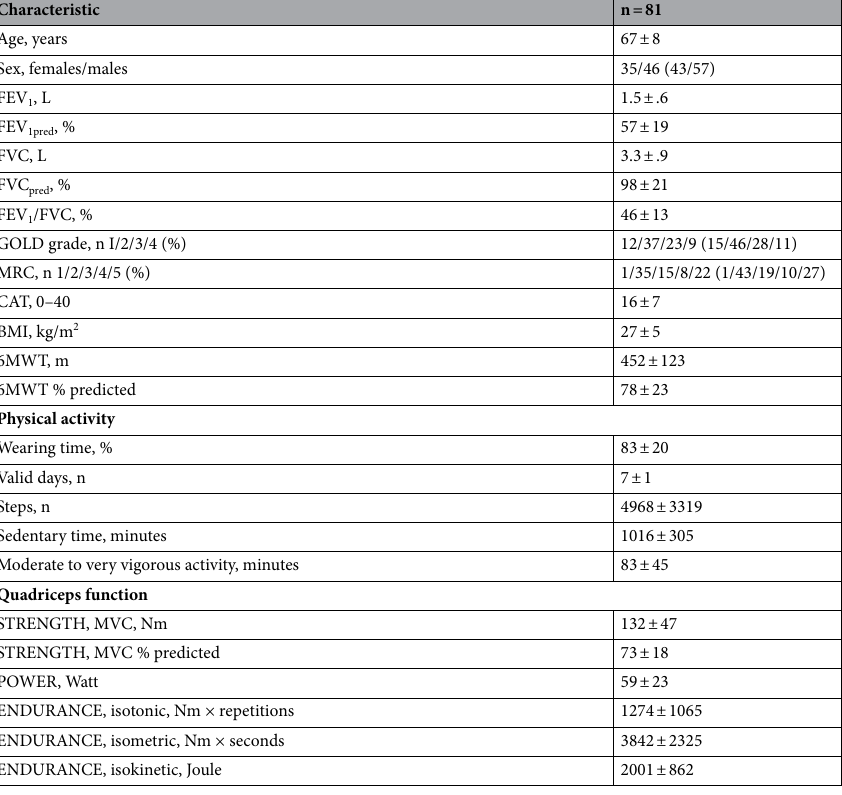
Table 1. Participant characteristics. Values are means ± standard deviations or number and (%). Activity measures are means of individual daily medians of minutes or steps, of at least four days of measurements and at least eight hours of wearing time. Thresholds for describing time spent at different intensity levels are proposed by the American College of Sports Medicine: Sedentary time < 1.5METs, time spent in moderate to very vigorous activty ≥ 3 to > 9 METs. FEV1 forced expiratory volume in the first second, FEV1pred FEV1 in percent of predicted, FVC forced vital capacity, FVCpred FVC in percent of predicted, GOLD Global Initiative for Lung Disease, MRC Medical Research Council dyspnea scale, CAT COPD assessment test higher values indicating more symptoms, BMI body mass index, 6MWT 6-minute walk test, MVC maximal isometric voluntary contraction, METs metabolic